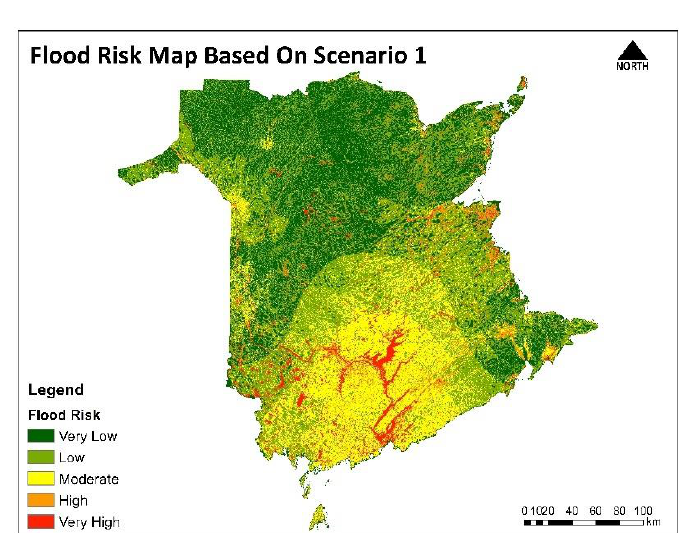
Figure A16. Land Use.